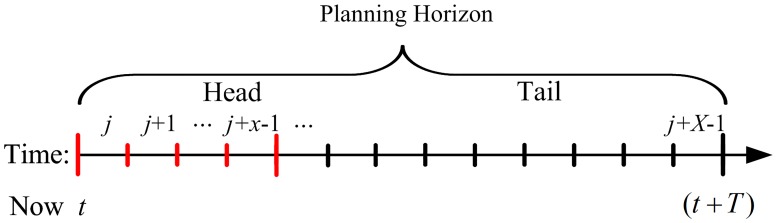
Division of planning horizon.